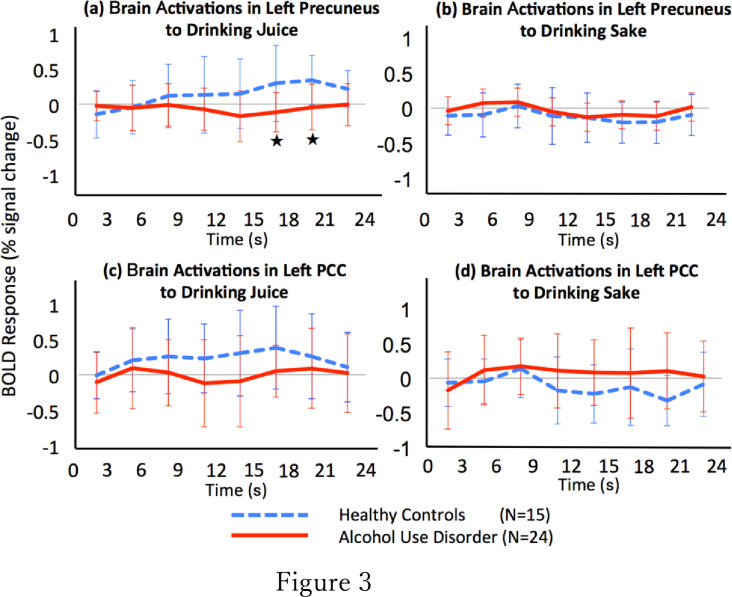
The time course of BOLD activation associated with behavioural cue reactivity for drinking juice or drinking sake in the left precuneus or left PCC.The x-axis indicates time (s), and the y-axis indicates percentage of BOLD signal change. The blue dotted lines and red lines indicate the percentages of BOLD signal change in the HC and AUD groups, respectively. The bars show each standard error. Compared with the HC group, the AUD group had a significantly decreased BOLD response in the left precuneus to the drinking juice stimulus from 15 to 21 s (★p < 0.0071) (a).